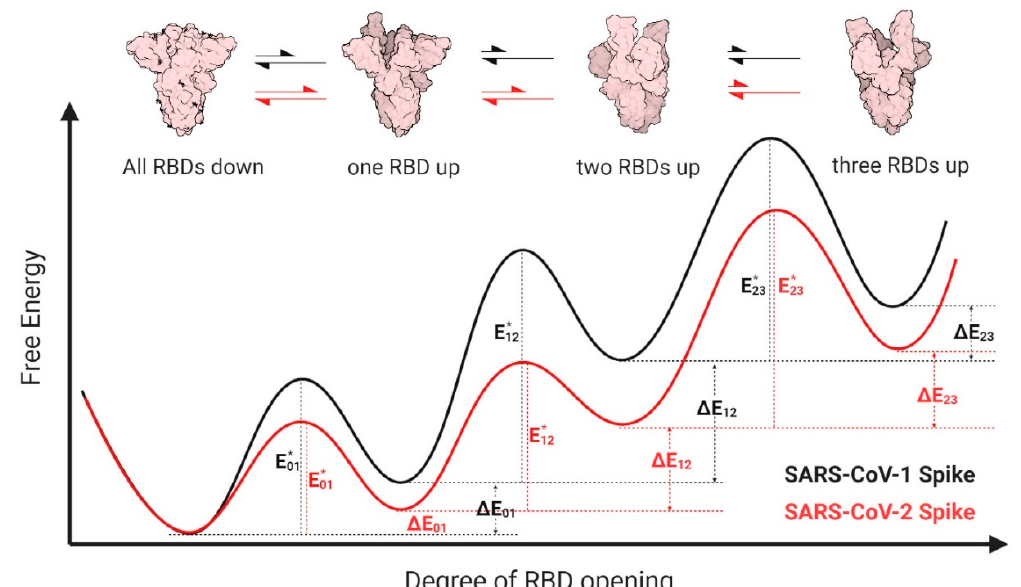
Figure 3. Proposed energy landscapes of spike trimer opening of SARS-CoV-2 and SARS-CoV-1. We assume conformational landscapes for both species of spikes (SARS-CoV-1: black; SARS-CoV-2: red) that permit equilibration among four distinct states: all- receptor-binding-domains (RBDs) -down (“0”), one-RBD-up (“1”), two-RBDs-up (“2”), and three-RBDs-up (“3”). We hypothesize that the SARS-CoV-2 spike energetic barrier for transitioning from all-RBDs-down to one-RBD-up ( 𝐸 (cid:2868)(cid:2869)∗ ) is lower for SARS-CoV-2 than for SARS-CoV-1, while both experience the same barrier for the reverse transition, making the one-RBD-up state more stable for SARS-CoV-2 than for SARS-CoV-1, as illustrated by the relative energy differences ∆𝐸 (cid:2868)(cid:2869) . However, SARS-CoV-1 spike likely needs to overcome substantially higher energy barriers to transit from the one-RBD-up state to the two-RBDs-up state ( 𝐸 (cid:2869)(cid:2870)∗ ), as compared with SARS-CoV-2 spike. This underlying conformational selection mechanism results in a larger population of SARS-CoV-2 spike in two or three RBDs up state and has higher chance to engage multiple ACE2, which eventually spurs the complete open and dissociation of S1 from S2 and induces membrane fusion. Cartoon representation of closed, one-RBD-up, two-RBDs-up states of spike were generated from deposited structures in Protein Data Bank (6ZWV, 6VSB, 6 × 2B, respectively). The three-RBDs-up model was generated by C3 symmetry superposition of three one-RBD-up protomer in 6VSB.